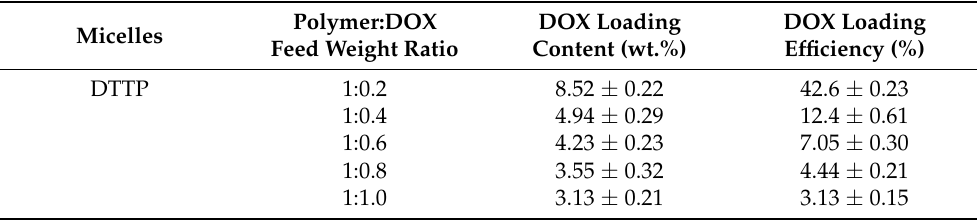
Table 1. DOX loading content and efficiency of DTTP micelles. Data are means ± S.D. of three independent